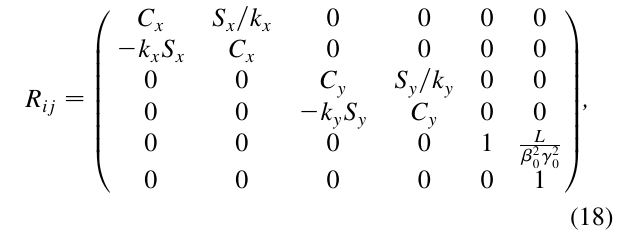
FIG. 1. The structure of the lattice period of S-LSR. The deflector can be used as both a dipole magnet and a dispersion and k are the values of the field gradient of the suppressor. k 1 2 quadrupole magnets.